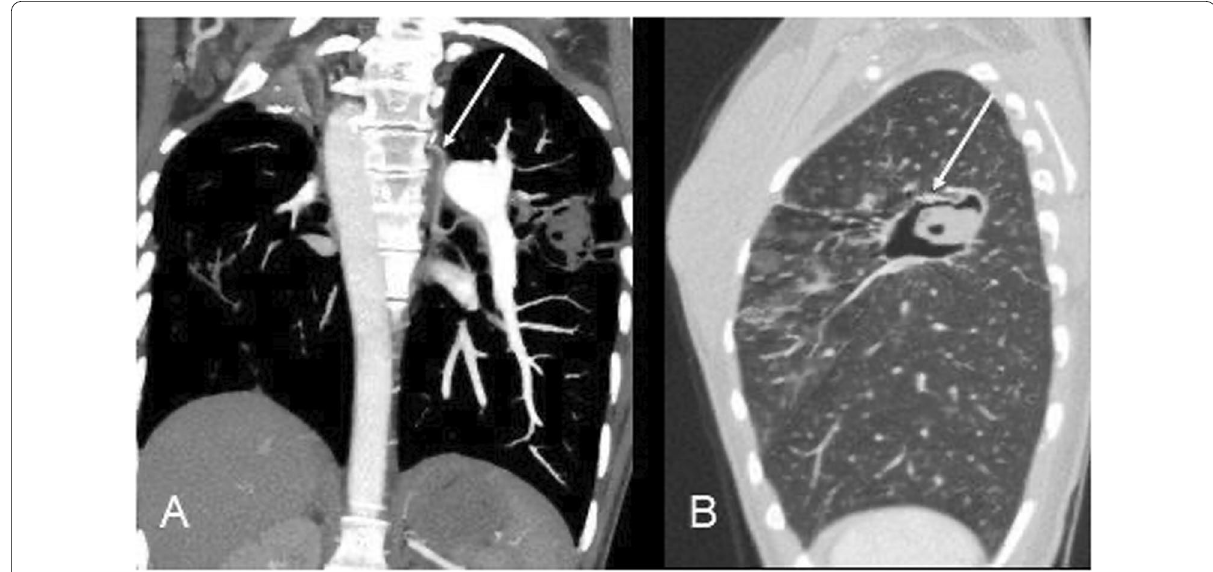
Fig. 1 A Coronal CT angiogram shows right-sided aortic arch with hypertrophied left bronchial artery (white arrow). B Sagittal HRCT chest image showing cavity with internal soft tissue in left upper lobe (white